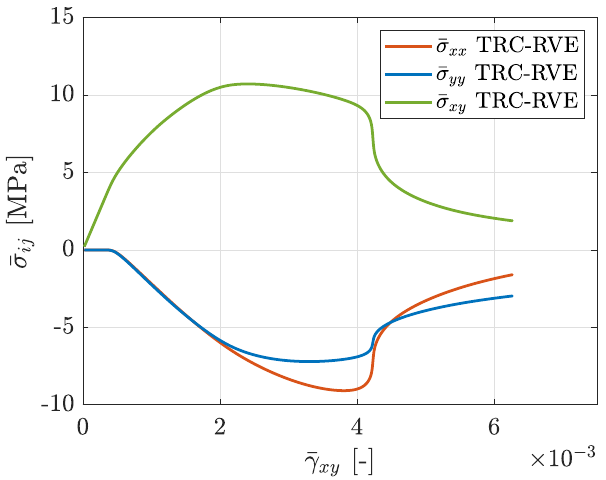
Figure 19. Effective macroscopic stress–strain relation due to in-plane shear loading with prescribed strain ¯ (cid:101) = [ ¯ (cid:101) xx = 0, ¯ (cid:101) yy = 0, ¯ γ xy ]